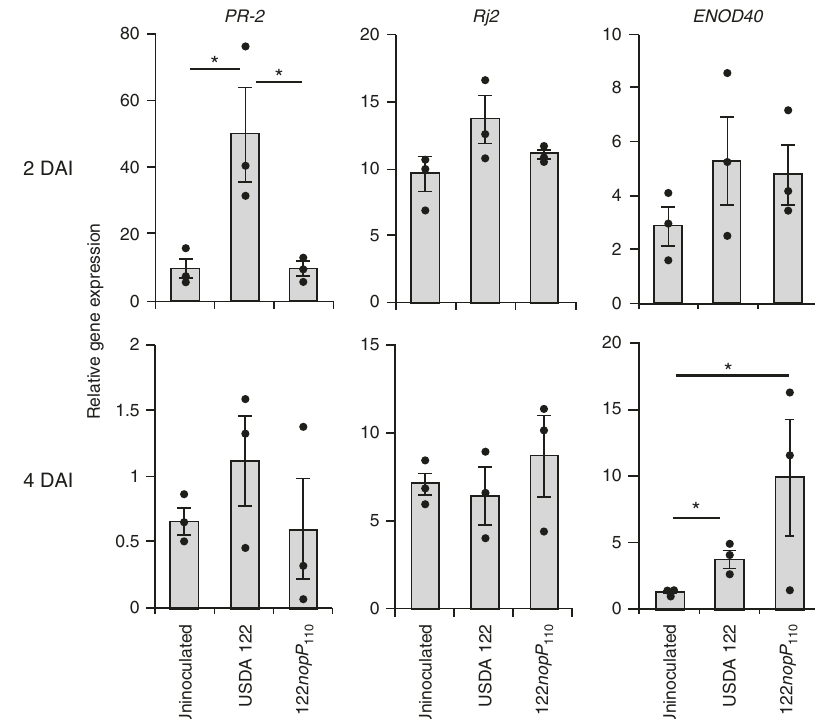
Fig. 6 Expression of PR-2 , Rj2 , and ENOD40 genes in roots of Hardee. Expression of PR-2 , Rj2 , and ENOD40 in roots of G. max cv. Hardee inoculated with USDA 122 and 122 nopP 110 was determined by quantitative reverse-transcription PCR using primers listed in Supplementary Data 2 as described in Methods. RNA was isolated from the roots at 2 and 4 days after inoculation (DAI). The expression level of each gene was normalized by the SUBI2 (ubiquitin) gene. Error bars show SEM of three independent experiments with two plants (from one seed pack). * P < 0.05 by two-tailed Student ’ s t